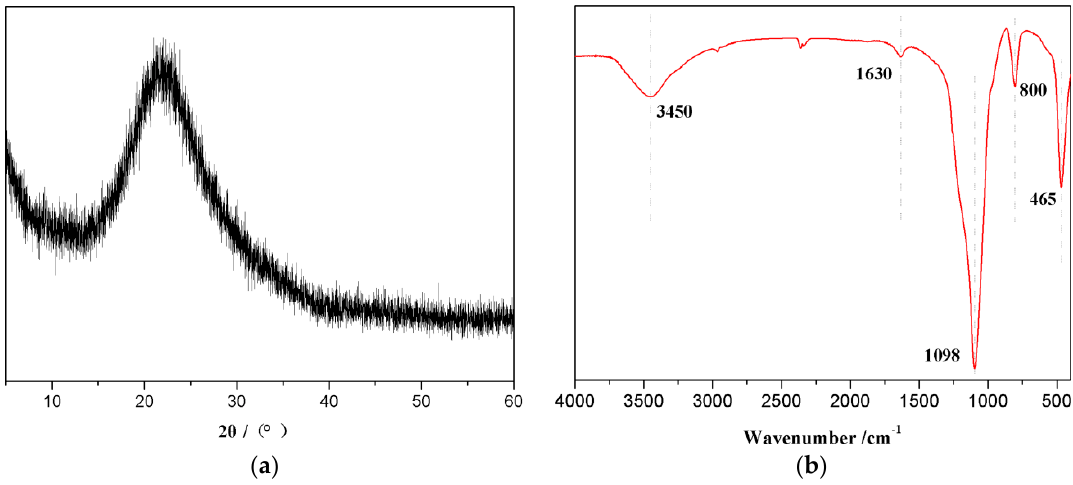
Figure 3. XRD pattern and the FTIR spectrum of pyrolysis obtained RHNS: ( a ) XRD pattern and ( b ) FTIR spectrum.